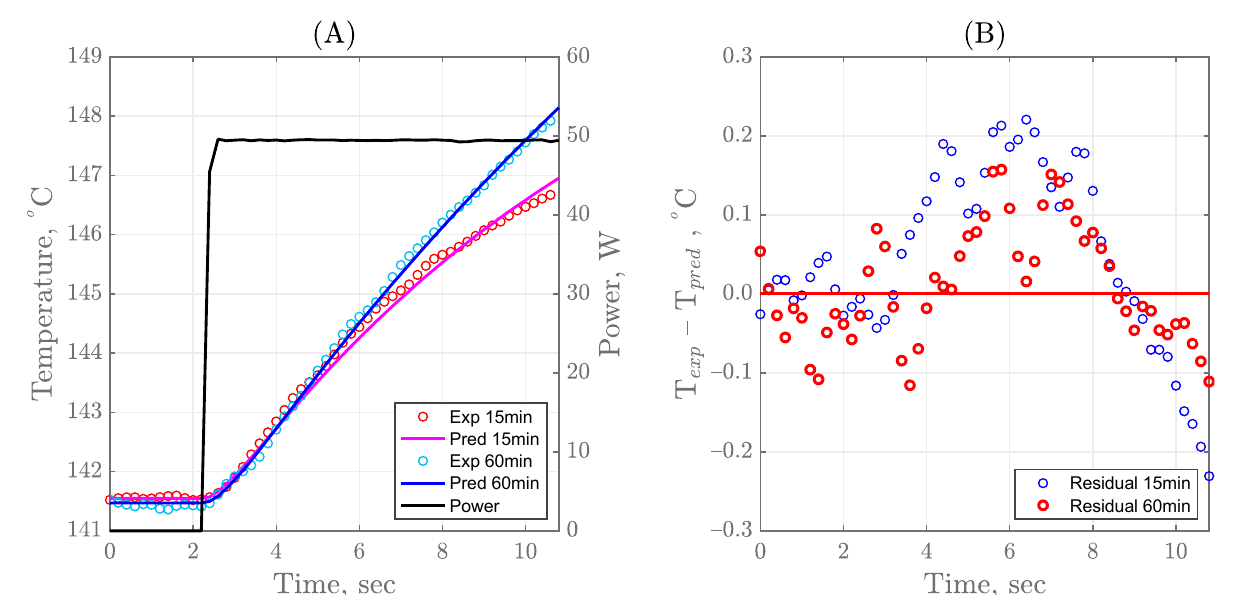
Figure 5. Temperature profile, ( A ) and residual plot, ( B ) for the sensor heat pulse at 15 and 60 min of processing HWC. Sensors 2021 , 21 , x FOR PEER REVIEW